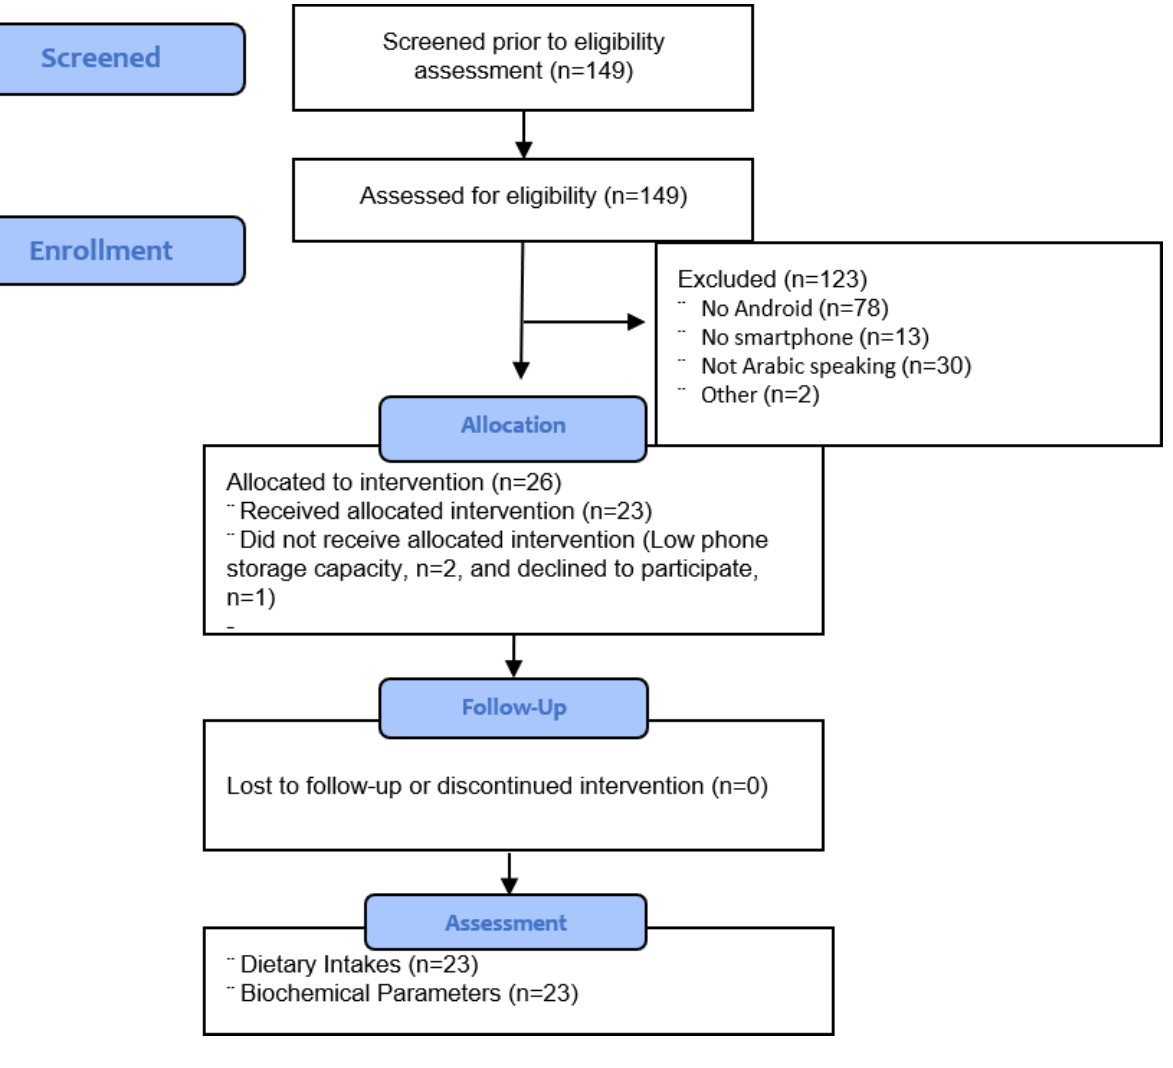
Figure 2. CONSORT study flow